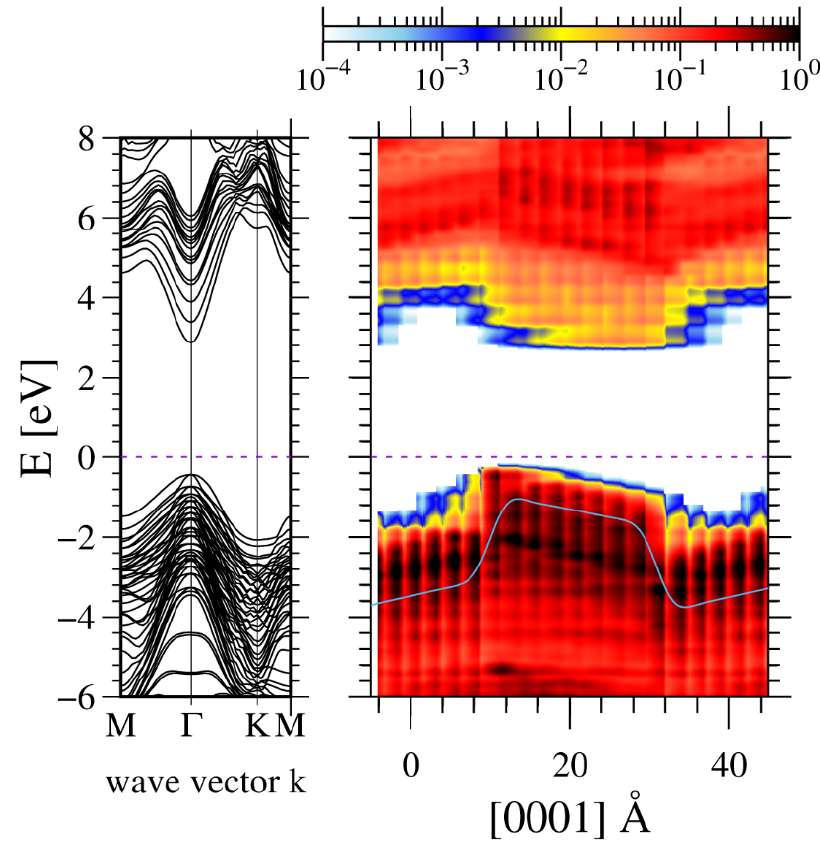
Figure 3. Ab-initio-calculated band profiles, obtained for 8AlN-8GaN atomic layers supercell with periodic boundary conditions: left panel—momentum space, right panel—real space. The blue line represents double averaged electric potential profile presented as electron energy [46]. GaN lattice was used in the entire system, by location of Ga and Al atoms in the lattice sites and subsequent relaxation along the c-axis.